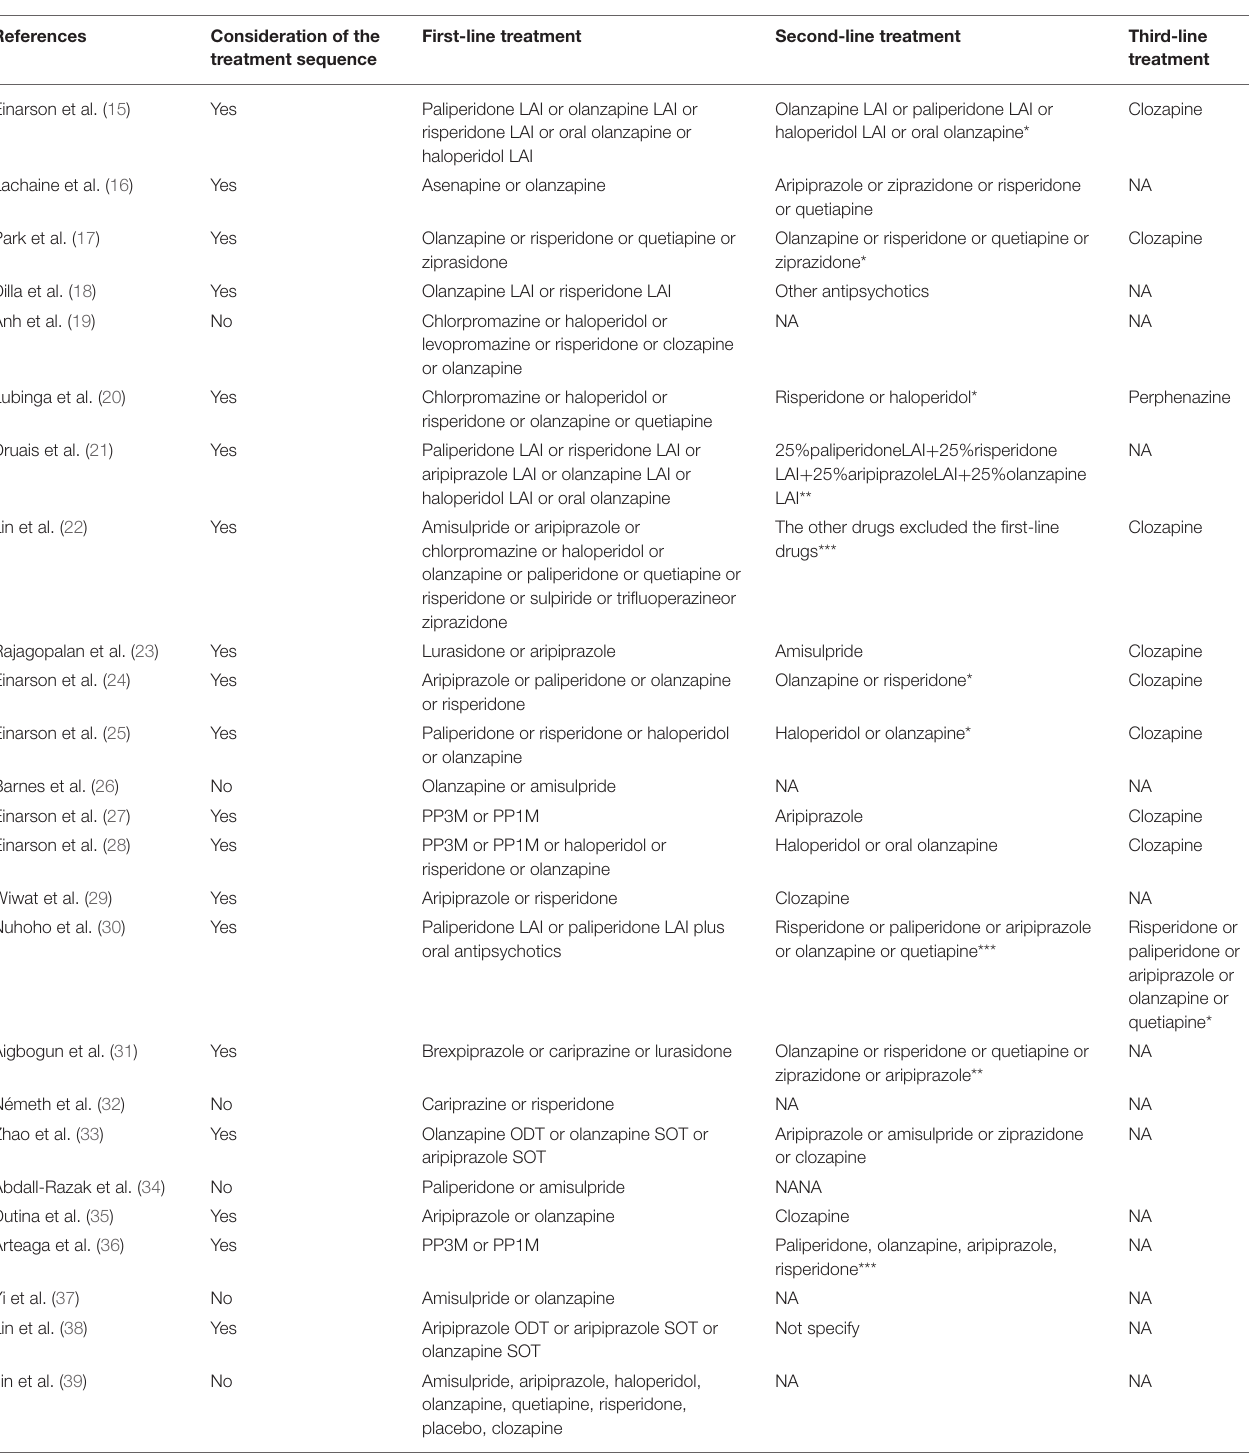
TABLE 2 | Treatment sequences # in the included